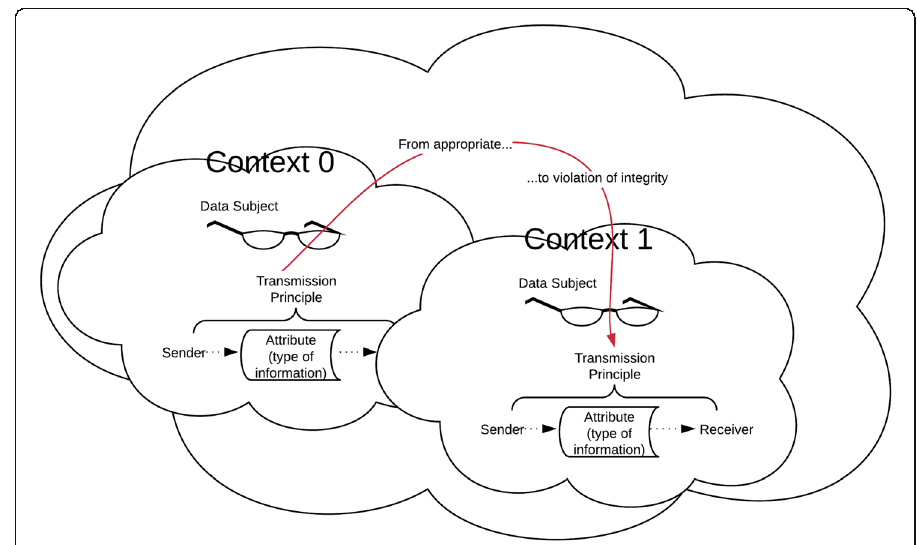
Fig. 5 Contexts as dynamic recursive settings defined by subject ’ s